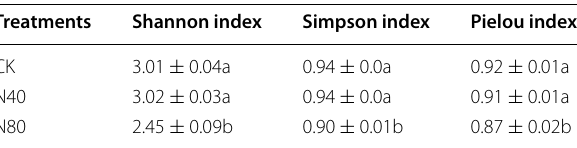
Table 2 Soil microbial functional diversity index under different nitrogen addition concentrations